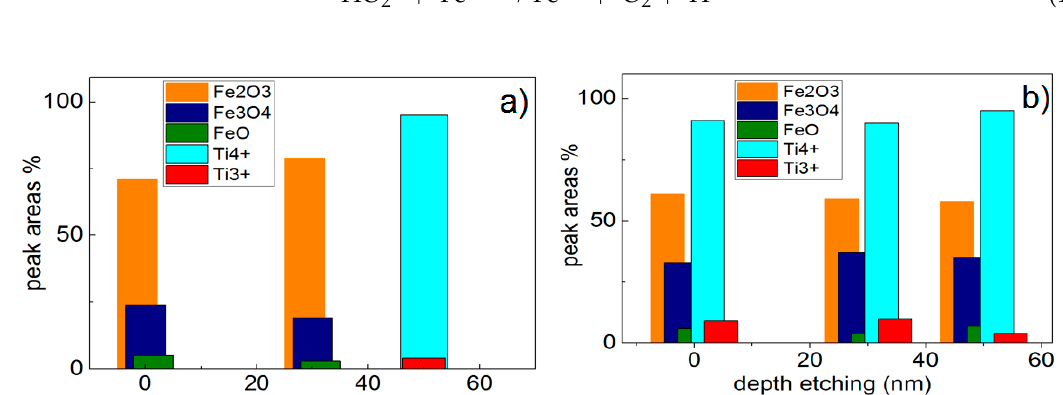
Figure 6. ( a ) Evolution of Ti2p and Fe2p oxidation states during bacterial inactivation as a function of the disinfection time, as determined by XPS for: ( a ) sequentially sputtered TiO 2 /FeO x –PE films, ( b ) co-sputtered TiO 2 –FeO x –PE films. Irradiation source: Suntest simulated (52 mW cm − 2 ) in the presence of a cut-off filter at 400 nm. Reprinted from [54].